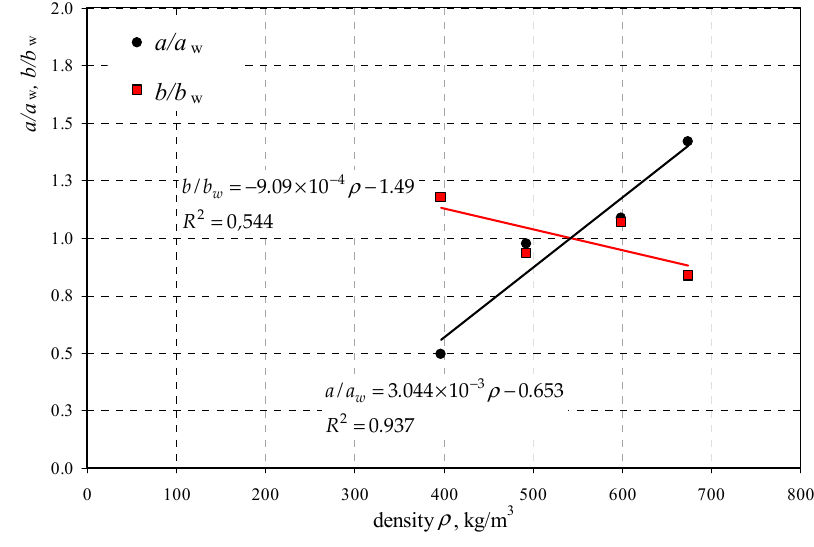
Figure 5. Relative coefficients of curves.